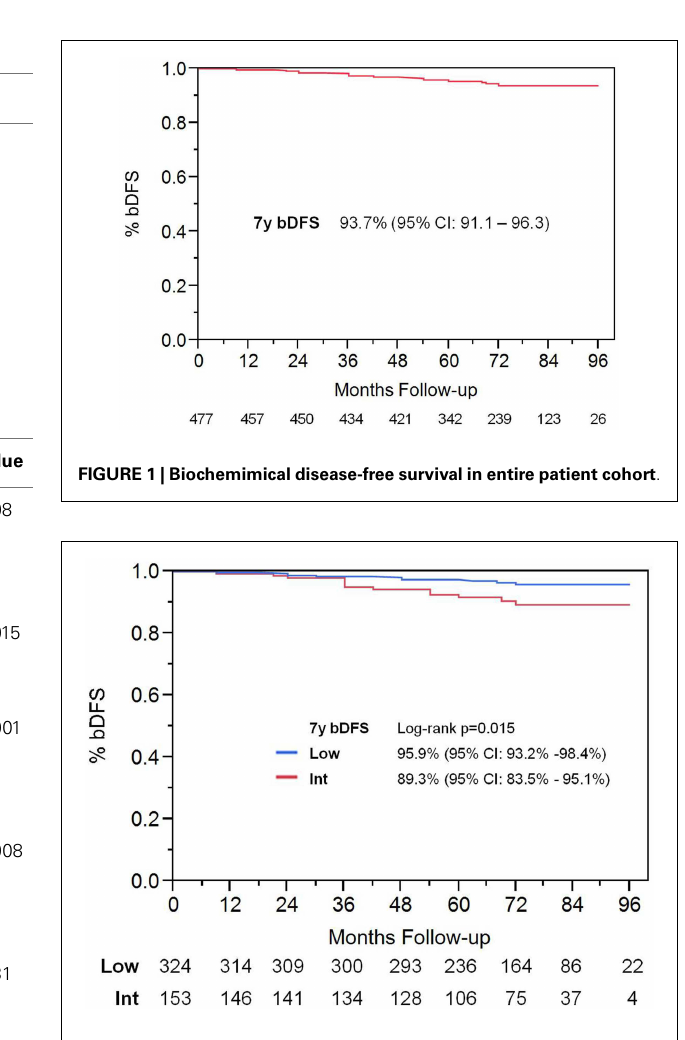
FIGURE 2 | Biochemical disease-free survival stratified by D’Amico risk group .